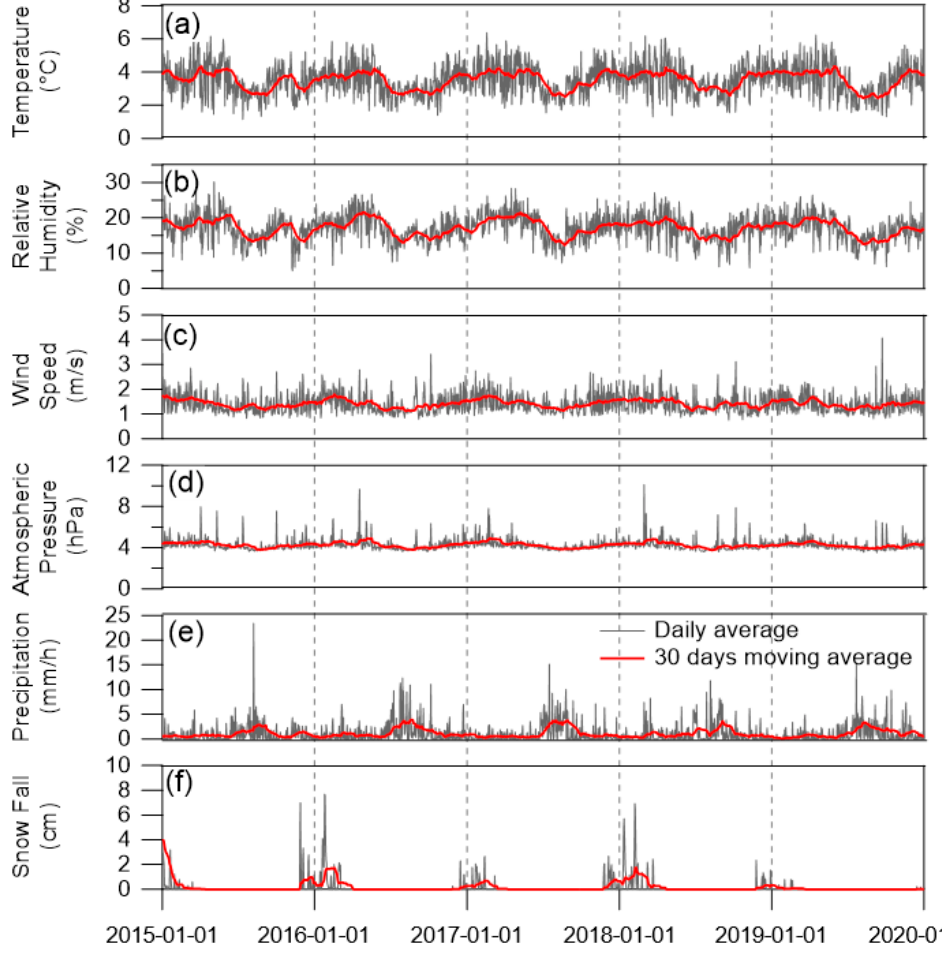
Figure 5. Daily standard deviation with 30 − day moving average for ( a ) Temperature, ( b ) Relative humidity, ( c ) Wind speed, ( d ) Atmospheric pressure, ( e ) Precipitation, and ( f ) Snow fall. Table 6. Correlations among next-day PM 2.5 and air pollutants (nationwide daily average and variance).